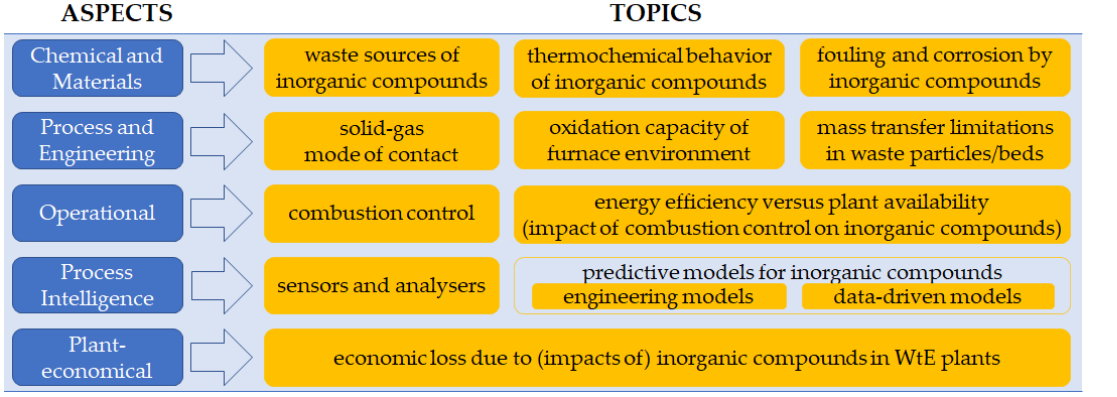
Figure 2. Overview of aspects and topics associated with the occurrence, behavior, and fate of inorganic compounds in industrial WtE combustion processes.